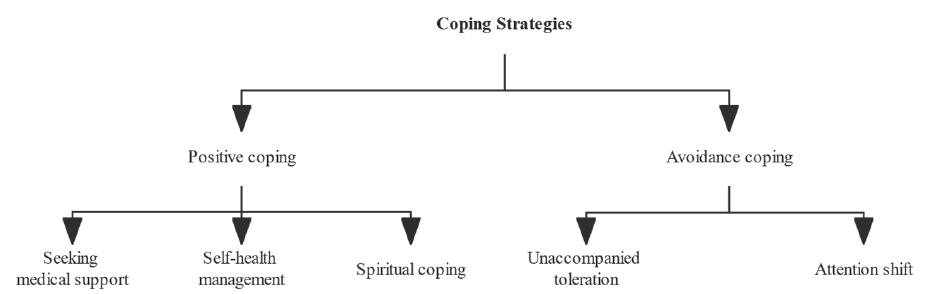
Figure 2. Theme analysis of coping strategies for fear of cancer recurrence.